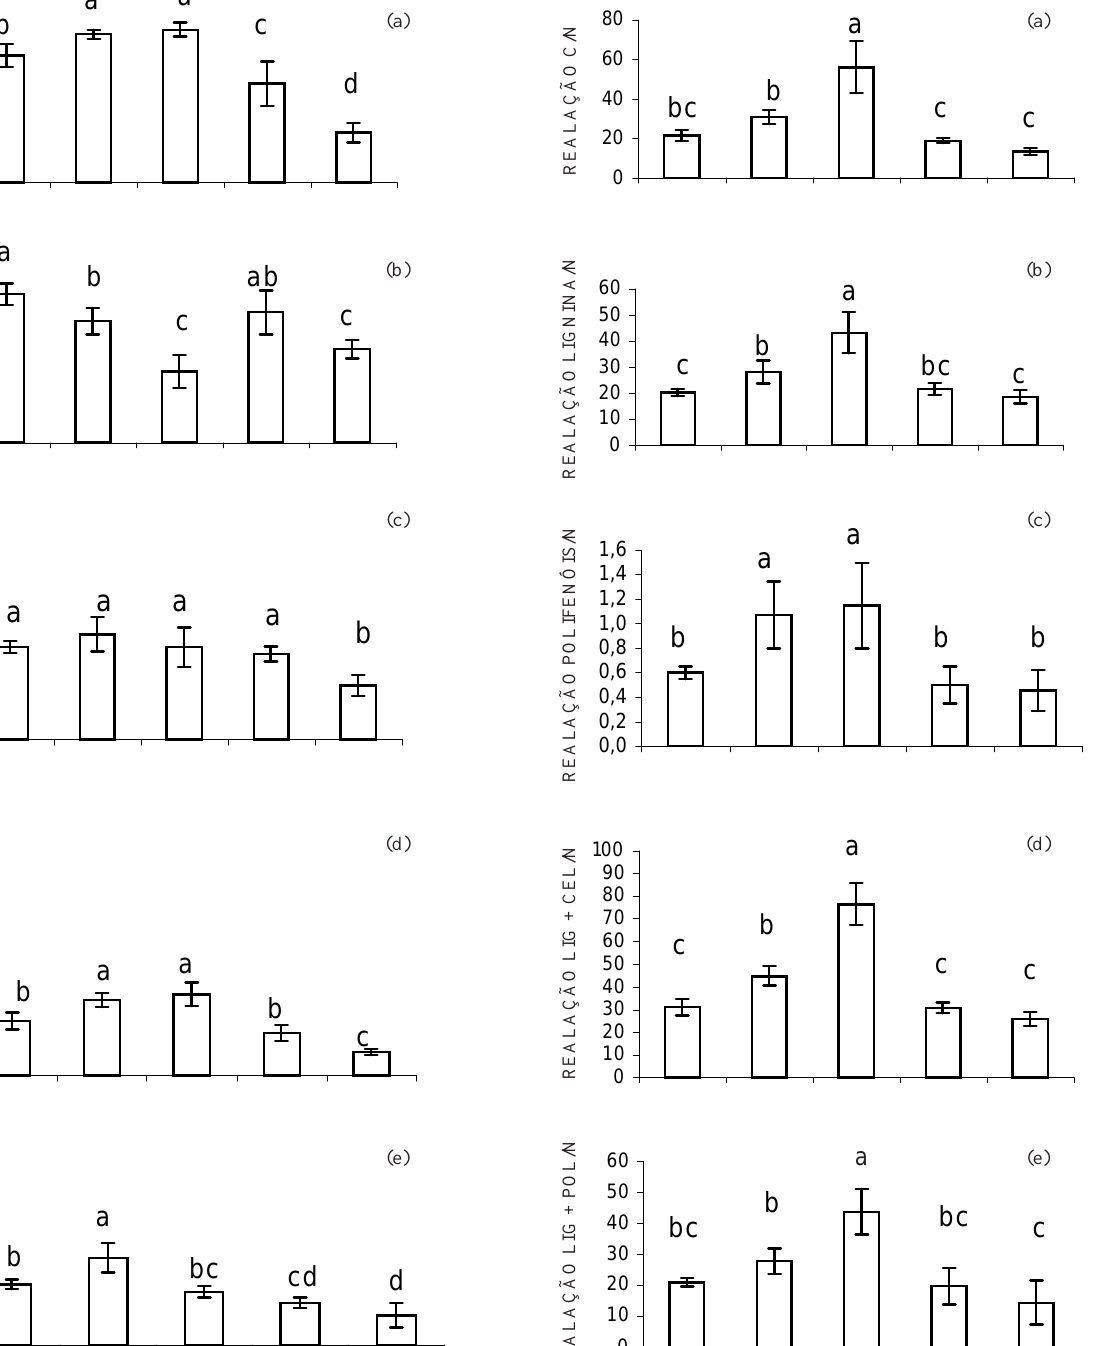
Figura 2. Atributos qualitativos das diferentes estruturas da serapilheira: Carbono orgânico (C), N total (N), lignina (Lig), celulose (Cel), polifenóis